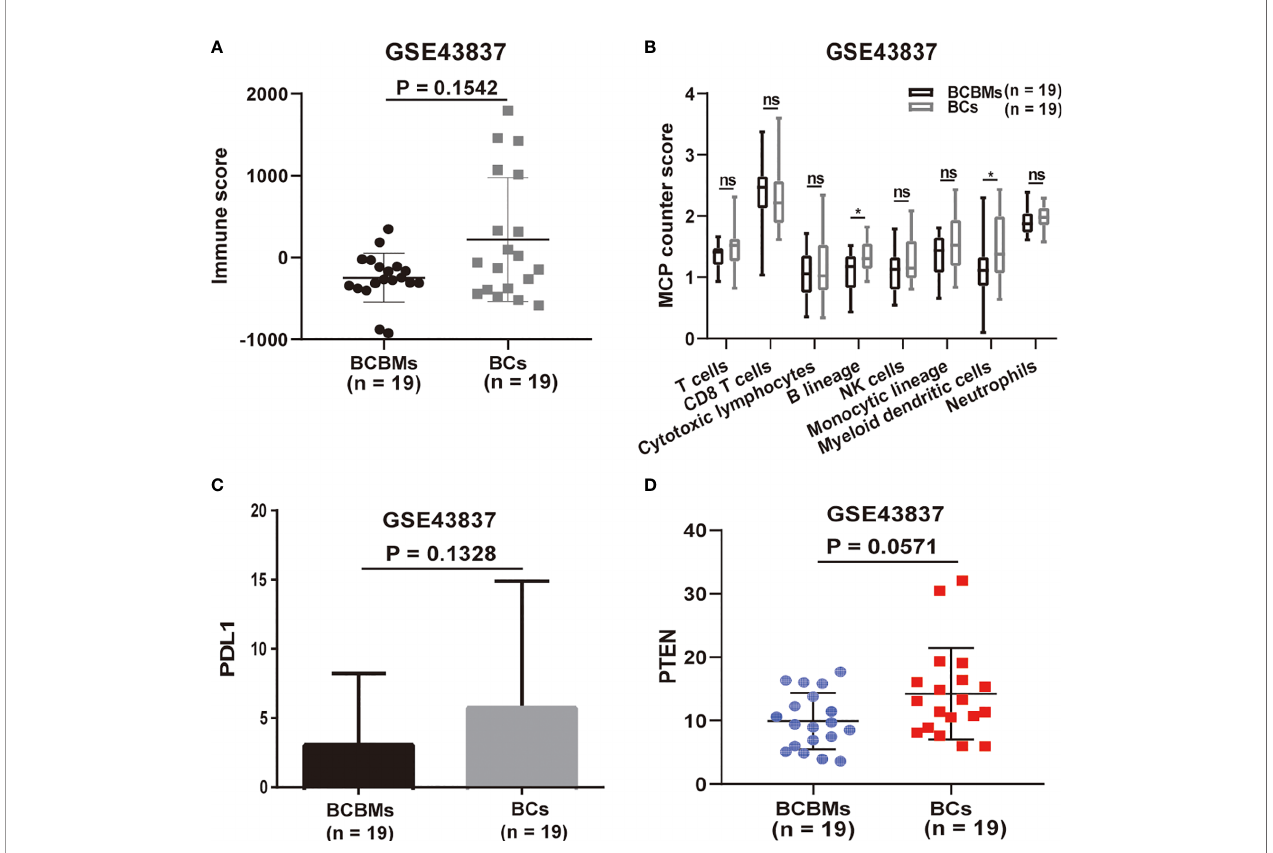
FIGURE 2 | Immune in fi ltration heterogeneity in BCBMs compared with BCs (GSE43837). (A) ESTIMATE immune analysis of BCBMs (n=19) and BCs (n=19) (GSE43837). Lines represent mean ± SD, and each dot represents a single sample. Signi fi cance was determined via Wilcoxon rank-sum test. (B) MCP-counter analysis of indicated immune cell populations in BCBMs (n = 19) and BCs (n = 19) from GSE43837. Each plot is a simple box and whisker plot. Median values (lines) and interquartile range (whisker) are indicated. ns, not signi fi cant (P > 0.05); *P < 0.05. Signi fi cance was determined via a Wilcoxon rank-sum test. (C) Comparison of CPM for PDL1 RNA expression between BCBMs (n = 19) and BCs (n = 19) from GSE43837. Lines represent mean ± SD. Signi fi cance was determined via Wilcoxon rank-sum test. (D) Comparison of CPM for PTEN RNA expression between BCBMs (n = 19) and BCs (n = 19) from GSE43837. Lines represent mean ± SD, and each dot represents a single sample. Signi fi cance was determined via Wilcoxon rank-sum